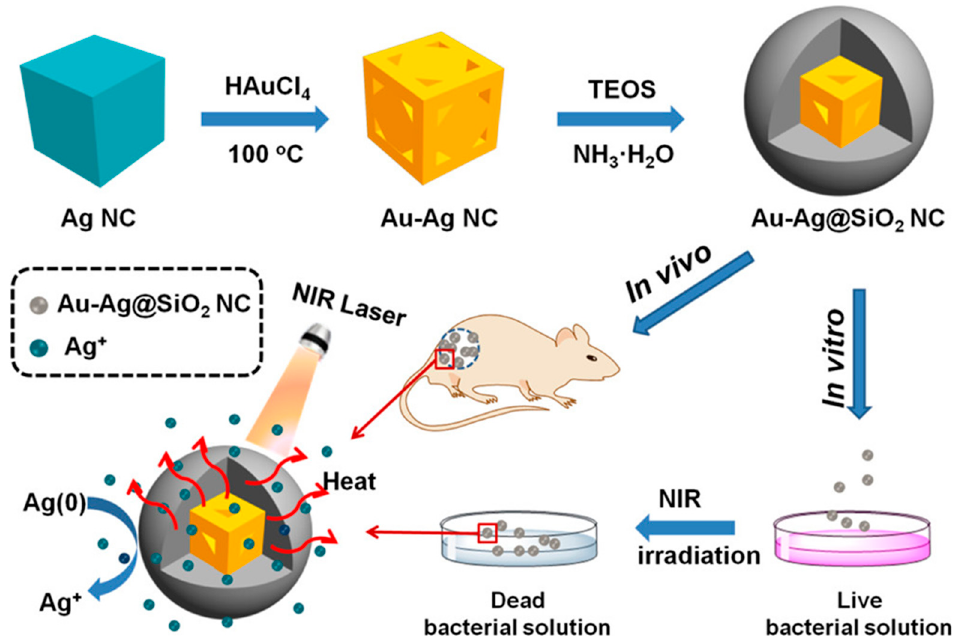
Figure 4. Silica-coated gold-silver nanocages (Au-Ag NCs) showing antibacterial activity by a photothermal effect. Reproduced from [46], with permission from American Chemical Society, 2019.